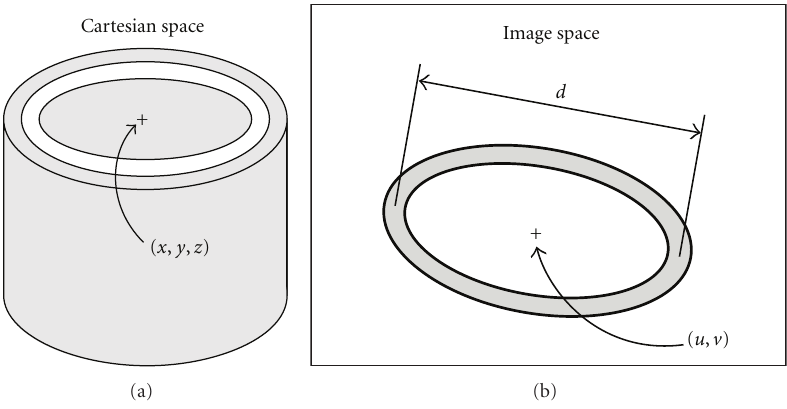
Figure 6: Visual pattern for the IBVS: coordinates in the Cartesian and image